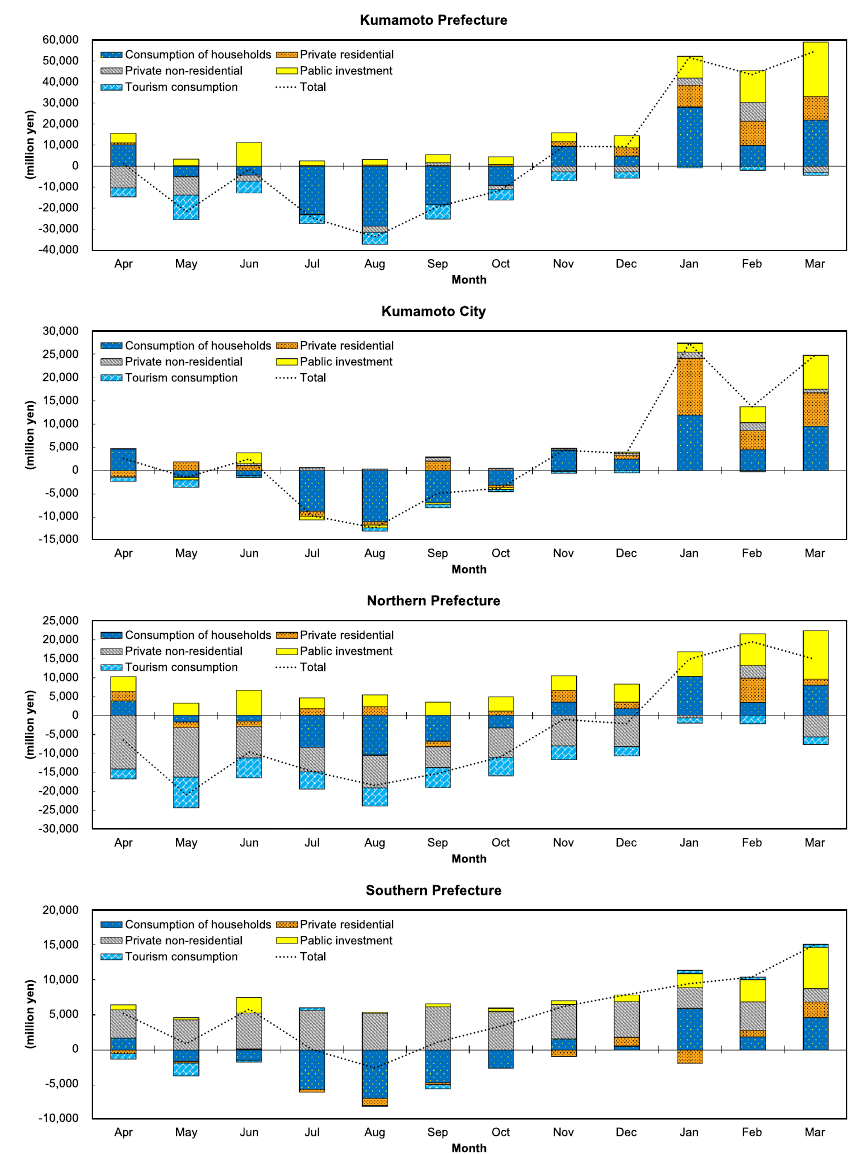
(cid:31) F k · l m by region and. (cid:31) k (cid:31) l (cid:31) F k · l m (cid:31) l